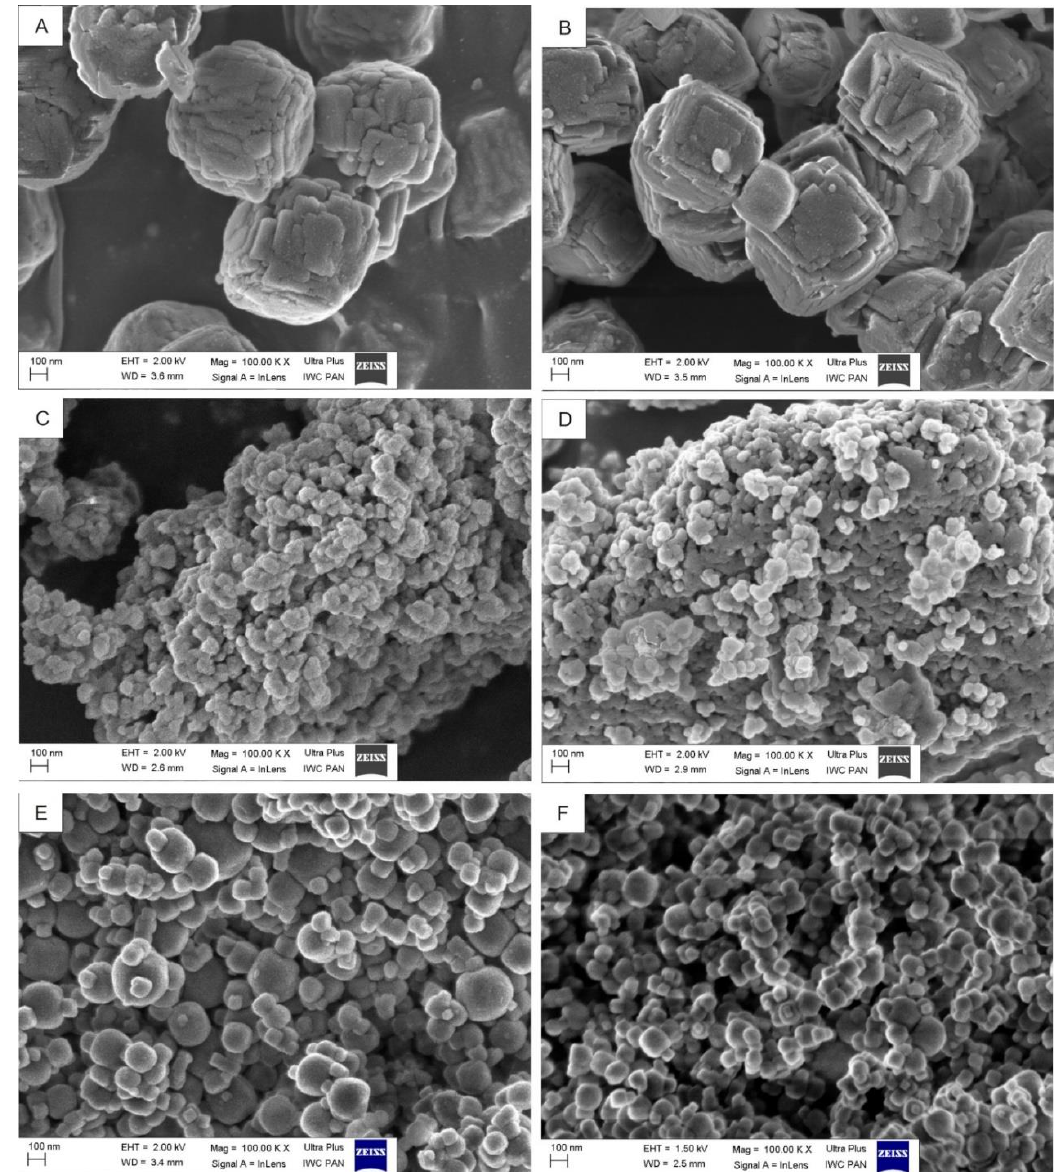
Figure 2. Representative scanning electron microscopy images of 6 NaA particle samples synthesized using different gel compositions and conditions of synthesis. ( A ) sample 1, ( B ) sample 2, ( C ) sample 3, ( D ) sample 4, ( E ) sample 5, ( F ) sample 6. Table 2. Characteristics of NaA samples: average crystal size according to SEM data and crystallinity according to X-ray diffraction.